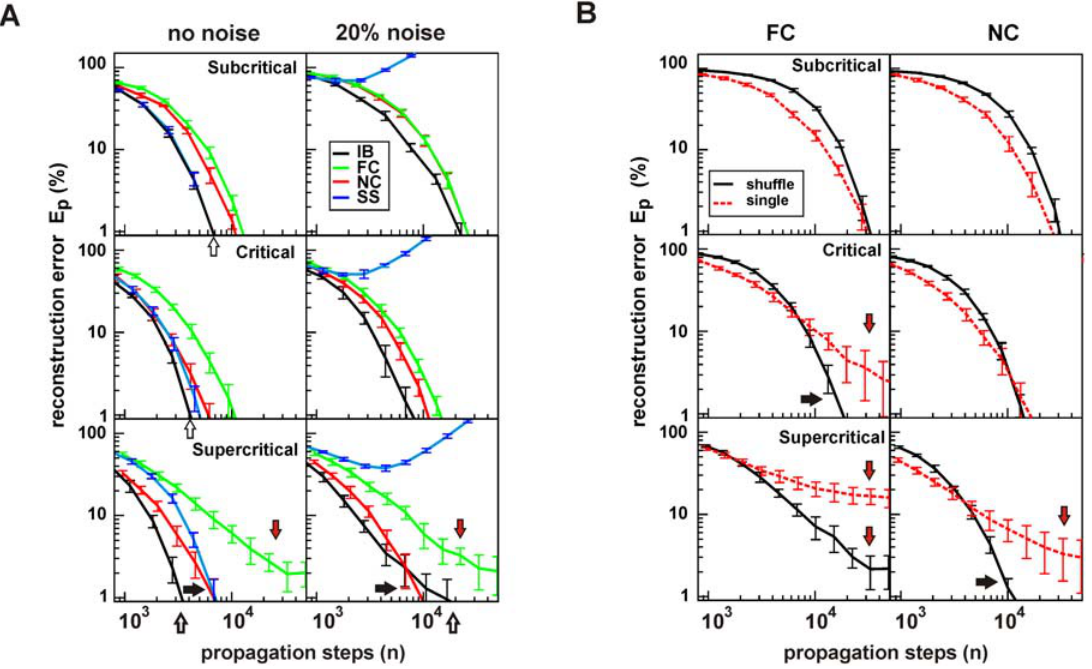
Figure 3. The NC algorithm (NC) performed robust and with high accuracy in both critical and supercritical regimes even in the presence of noise. (A) Reconstruction error E p relative to the original ER network for the four algorithms and all three dynamical regimes N ~ 60, S k d T ~ 10 ð Þ . Left: without noise. Right: with 20% noise. Open arrow: total number of reconstruction steps to reach 1% accuracy for the IB algorithm (benchmark). (B) The NC algorithm in combination with shuffling is required to reconstruct ER networks for all three dynamical regimes. E p is plotted against the number of propagation steps without shuffling (red broken line, single) and with shuffling (black solid line, shuffle) for the FC (left) and NC algorithm (right). Same network condition as in (A) with 20% noise. Note the robust performance of NC with shuffling in the supercritical regime. Arrows: reconstruction failure (red), success (black), see text. SS: Single Source. FC: Full Count. NC: Normalized Count. IB: Iterative Bayesian. Mean and SD obtained from 10 network simulation